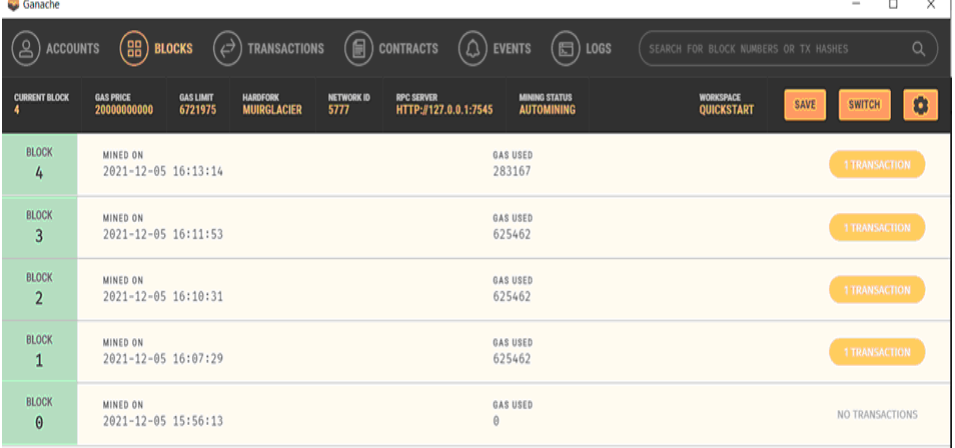
Figure 11. Deployment and running of transaction.